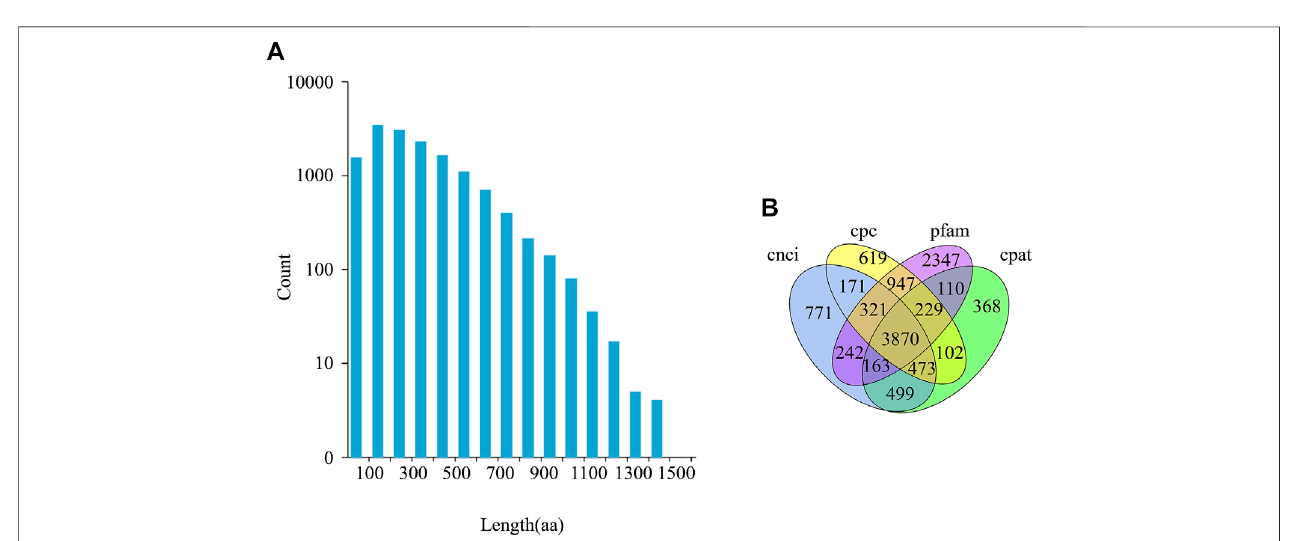
FIGURE 1 | CDS (Coding Sequence) length distribution and lncRNA prediction. (A) The length distribution of the entire ORF region coded protein sequence predicted by CDS. aa stands for amino acid. (B) Venn diagram of lncRNA, predicted using CPC (Coding Potential Calculator), CNCI (Coding-Non-Coding Index), CPAT (Coding Potential Assessment Tool), and Pfam (Protein families).